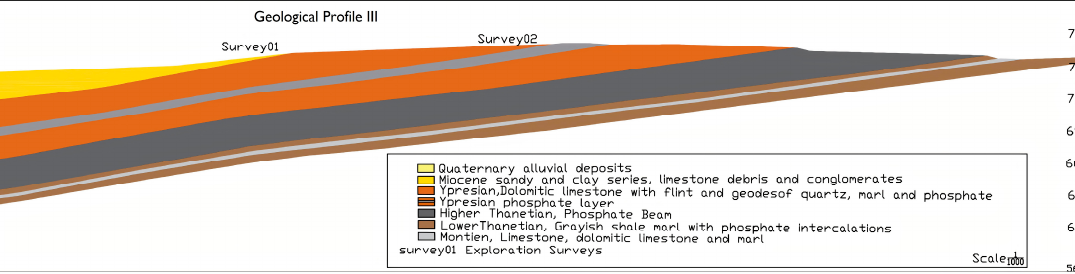
Figure 3. Sequencing of bloc extraction in the first exploitation phase. Two blocks with the same number mean that they are exploited at the same time. The mine parameters (bench height, slope, and platform length) were selected ac- cording to Algerian mining legislation; the maximum bench height is usually about 15 m for rock and 5 m for sand, for the safety of the mine as well as of the workers. The need to exploit each of the ore layers with a different bench was considered a restriction. This entails analysing distinct procedures for extraction, loading, and transportation to ensure the best operational performance on each court due to its different characteristics. For planning purposes, platforms with lengths ranging from 25 m to 75 m were considered. These values were determined according to the deposit’s features, the sequences defined for exploitation, the chosen equipment for the extraction, and the loading and transporta- tion procedures in open-pit operations. The slope of the designed benches was about 15°.